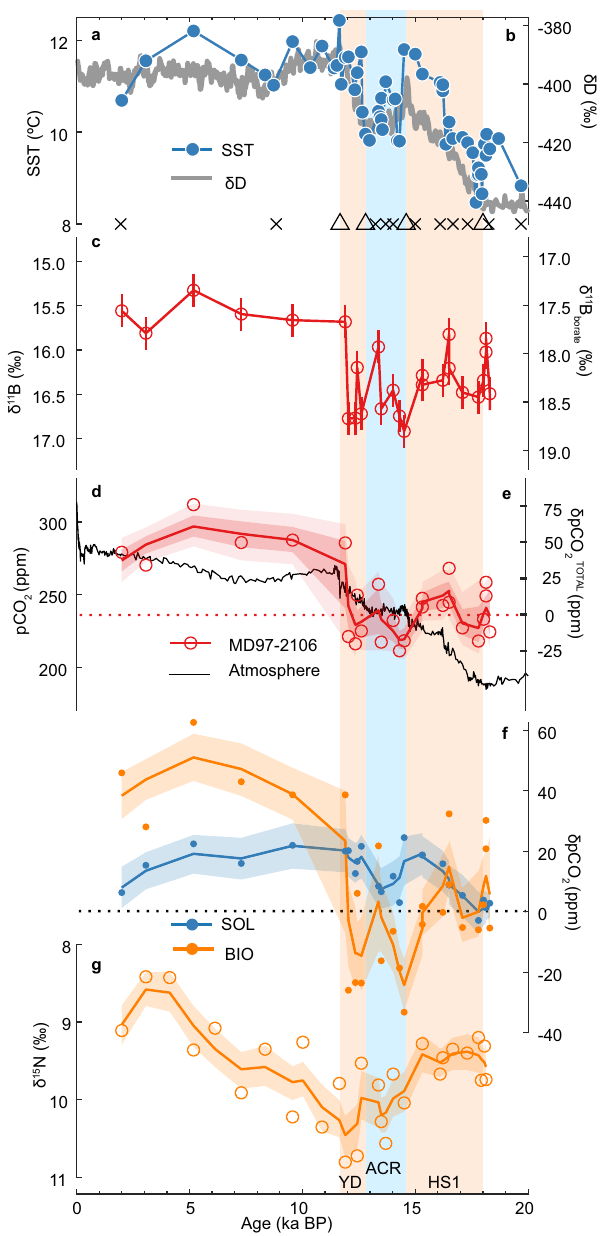
Fig. 2 | Surface-water reconstructions at site MD97-2106. a Sea surface tem- perature (SST) reconstructed from planktic foraminiferal Mg/Ca 36 (blue circles, left axis). b Antarctic temperature changes represented by δ D 26 (gray curve, right axis). Crosses and triangles at the bottom are age control points based on planktic radiocarbon dating and SST- δ D matching, respectively. c Planktic foraminiferal δ 11 B andseawaterborate δ 11 Bwitherrorbarsshowing±2 σ uncertainties. d Reconstructed surface-water pCO 2 at site MD97-2106 (red circles) compared with atmospheric pCO 2 recordedintheAntarcticicecores(blackcurve) 43,44 (leftaxis). e Totalsurface- water pCO 2 change relative to 18 ka ( δ pCO 2 TOTAL ) at site MD97-2106 (right axis). f Deglacial surface-water pCO 2 attributed to the solubility and biological pumps ( δ pCO 2 SOL and δ pCO 2 BIO , blue and orange dots, respectively) at site MD97-2106. g Foraminifera-bound δ 15 N, a proxy re fl ecting surface nutrient utilization. Curves in d – g arederivedfromaLOESSsmoother.In d ,lightanddarkenvelopes,respectively, represent 2.3 – 97.7% (roughly ±2 σ ) and 15.9 – 84.1% (roughly ±1 σ ) uncertainty ranges of timeseries incorporating uncertainties from measurements, all individual para- metersused forcalculations,and agemodels.In f and g only15.9 – 84.1% uncertainty rangesareshownforclarify.TheverticalpaleorangebarsrepresentHeinrichStadial 1 (HS1; ~18.0 – 14.6 ka BP) and the Younger Dryas (YD; ~12.8 – 11.7 ka BP). The vertical pale blue bar represents the Antarctic Cold Reversal (ACR; ~14.6 – 12.8 ka BP). δ pCO δ pCO 2 SOL and 2 BIO ( f )showsimilarstructurestoSST( a )andforaminifera-bound δ 15 N ( g ),